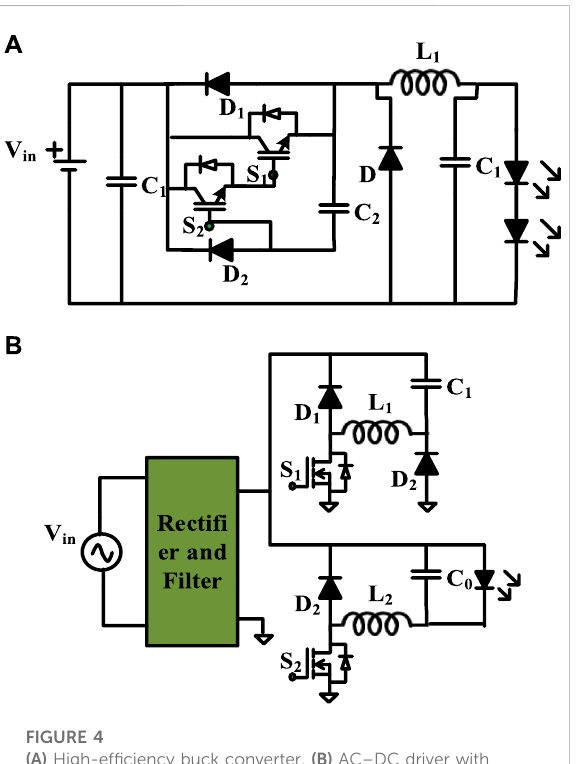
FIGURE 4 (A) High-ef fi ciency buck converter. (B) AC – DC driver with two parallel-connected buck converter.